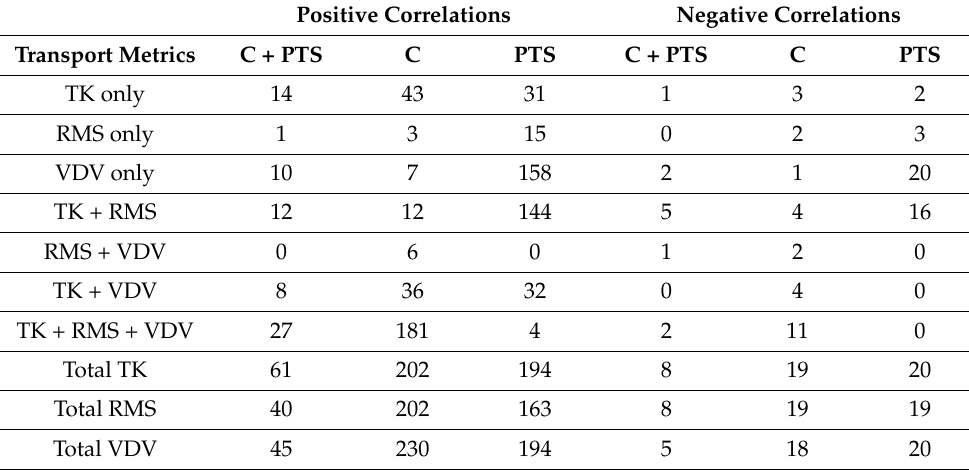
Table 3. Correlations of protein group intensities with transport metrics. The numbers of protein groups significantly correlating ( p ≤ 0.05) with transport metrics are reported on the left for positive correlation, and on the right for anti-correlation. C and PTS were both pooled (C + PTS) and considered separately.